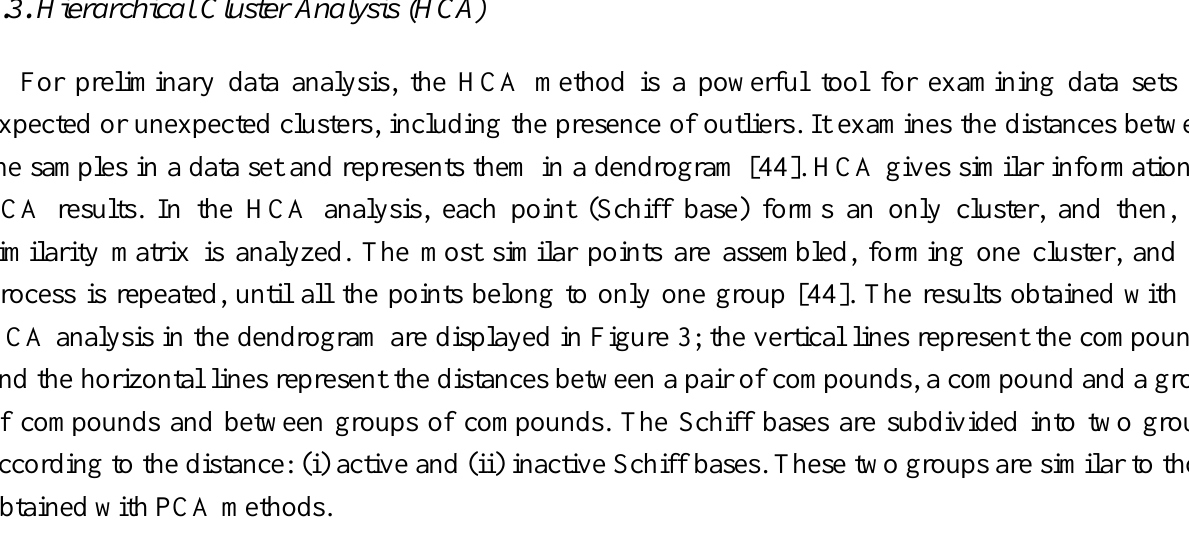
Figure 3. Dendrogram obtained with hierarchical cluster analysis (HCA) for Schiff